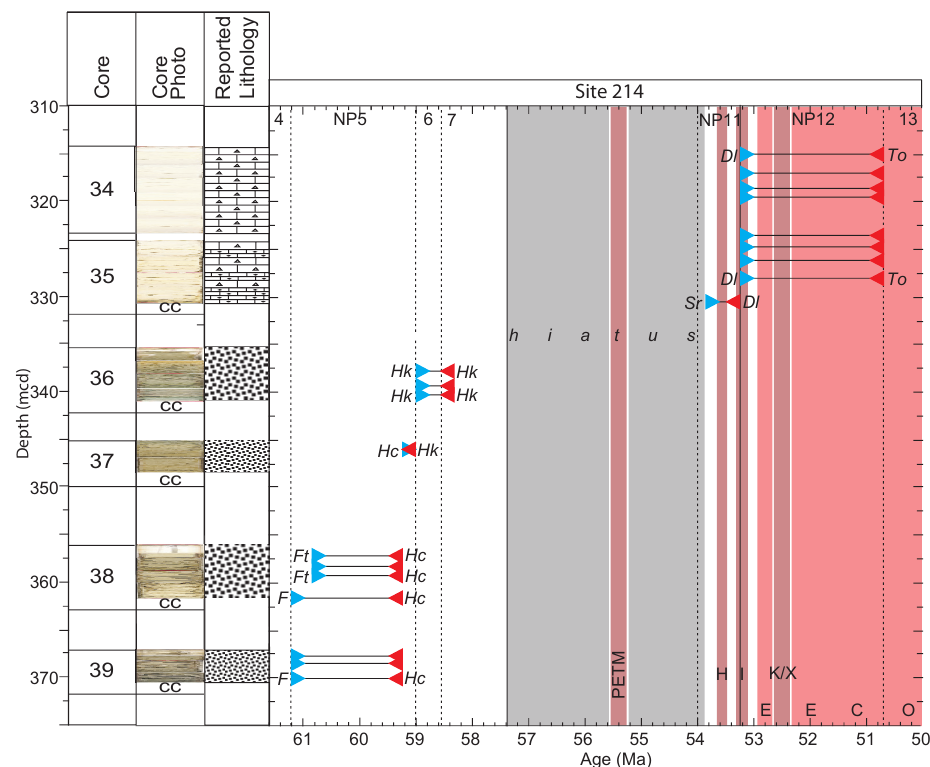
Figure 4. The depths of key nannofossil datums (bases – blue triangles; tops – red triangles) identified at Site 214. To and Dl indicate presence of both T. orthostylus and D. lodoensis . Dl and Sr indicate absence of D. lodoensis and presence of S. radians . Hk indicates presence of H. kleinpellii . Hk and Hc indicate absence of H. kleinpellii and presence of H. cantabriae . Hc and Ft indicate absence of H. cantabriae and presence of F. tympaniformis . Hc and F indicate absence of H. cantabriae and presence of Fasciculithus spp. (poor preservation only permits recognition at the genus level). Age estimates from Agnini et al. (2006, 2007) and calcareous nannofossil NP biozones from Martini (1971). Solid black vertical lines denote precisely known NP biozone boundaries; lines are dashed if boundary is not precisely known. Note lithological facies key in Fig.